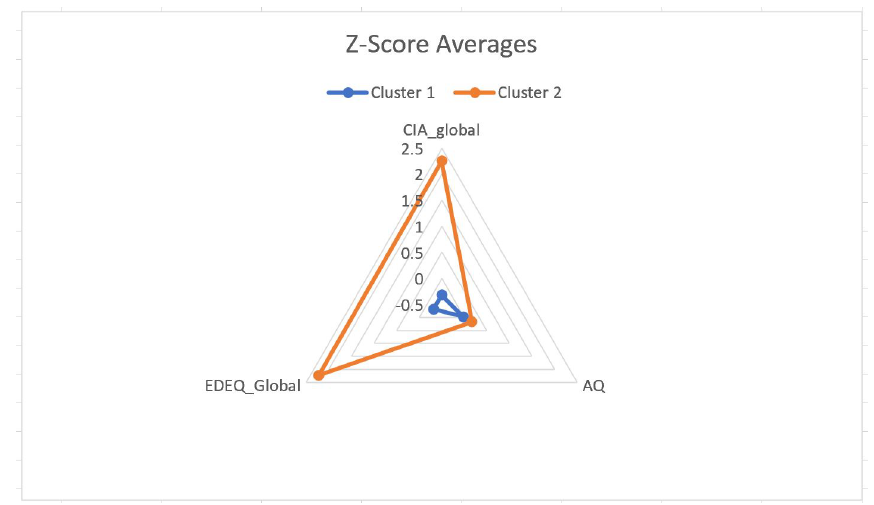
Figure 5. Radar plot of results when using z-score to scale the